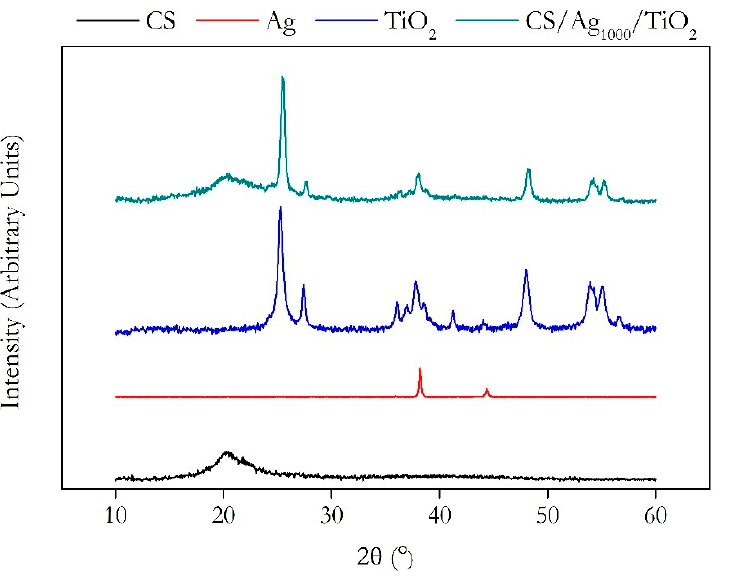
Figure 2. X-ray diffraction patterns of chitosan (CS), silver reference (Ag), P25 (TiO 2 ) and Ag/TiO 2 embedded in the chitosan scaffold (CS/Ag 1000 /TiO 2 ).